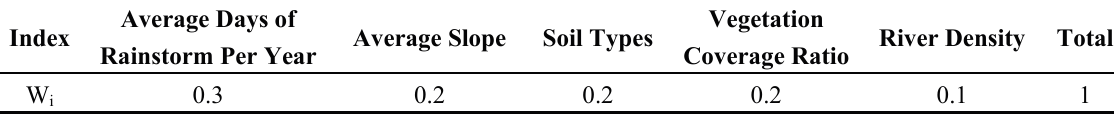
Table 3. Weight of